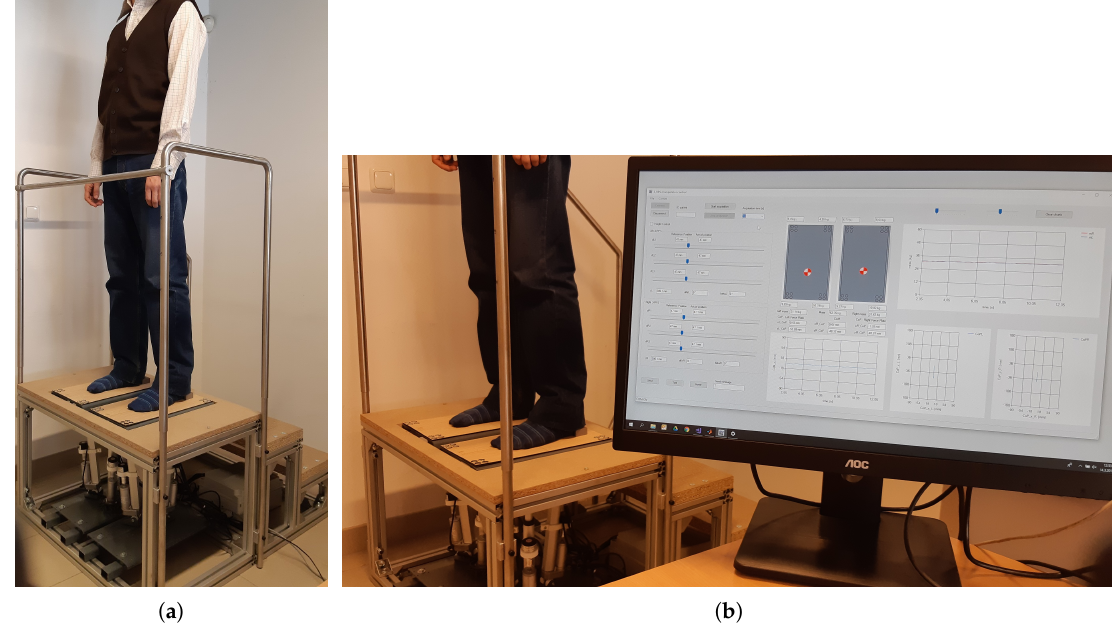
Figure 5. Display of the mechanical set with two 3-RPS parallel manipulators with moving force plates: ( a ) with the patient on the force plates; and ( b ) with the application used to diagnose the load on each of the patient’s